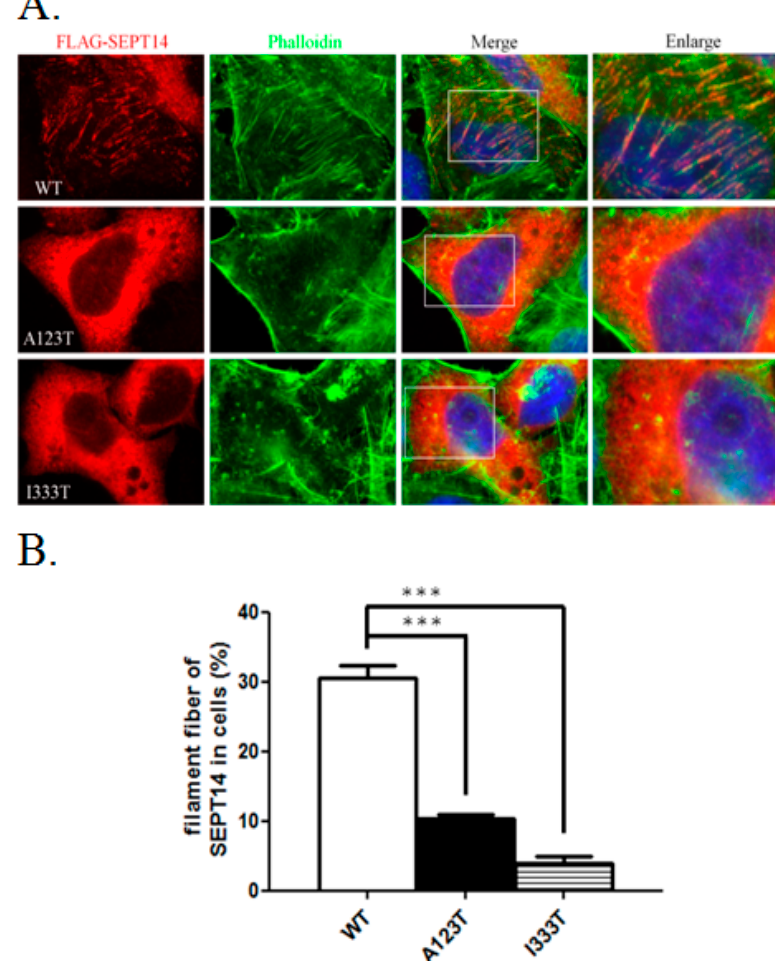
Figure 4. Filament forming ability of WT- SEPT14 and mutant SEPT14. ( A ) Immunofluorescence staining of the cells transfected with plasmids encoding WT FLAG- SEPT14 (WT panel), FLAG- SEPT14 A123T (A123T panel), and FLAG- SEPT14 I333T (I333T panel). From left to right: Staining with anti-FLAG antibody ( SEPT14 ), staining with phalloidin (phalloidin), merging with the figures of staining with anti-FLAG antibody, phalloidin, and DAPI (merge), and enlarged figure (enlarge). ( B ) The quantification bar chart was based on the observation of more than 100 cells for each experiment in Figure 4A. Filament fibers indicate the percentages of cells with SEPT14 filaments. ( p < 0.01, Student’s t test comparing filament fibers to others). Data are represented as means ± standard error of three tests.